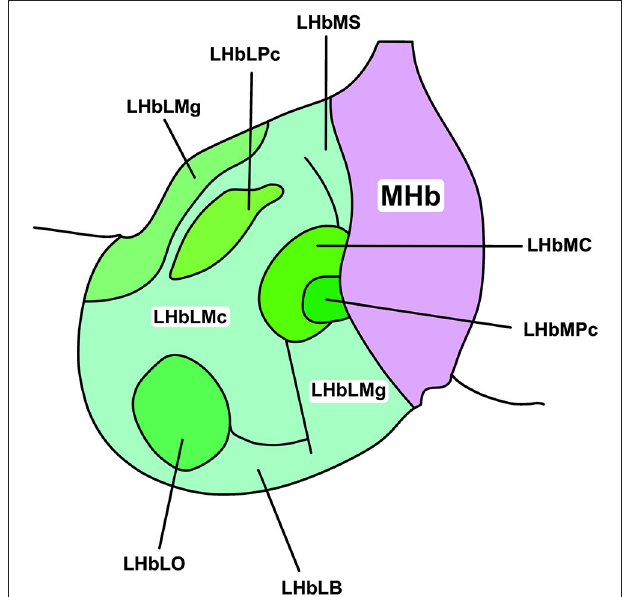
FIGURE 1 | Subnuclear organisation of the rat LHb. The habenular complex can be divided into lateral and medial subdivisions (LHb and MHb, respectively). The LHb can be further divided into medial and lateral regions (LHbL and LHbM, respectively), and thus into nine cytochemically, topographically, and morphologically distinct subnuclei. These include, in the LHbL: the marginal subnucleus of the LHbL (LHbLMg), the magnocellular subnucleus of the LHbL (LHbLMc), the oval subnucleus of the LHbL (LHbLO), the basal subnucleus of the LHbL (LHbLB), and the parvocellular subnucleus of the LHbL (LHbLPc). In the LHbM: the superior subnucleus of the LHbM (LHbMS), the central subnucleus of the LHbM (LHbMC), the parvocellular subnucleus of the LHbM (LHbMPc), and the marginal subnucleus of the LHbM (LHbMMg). Redrawn and adapted from Wagner et al. (2014).